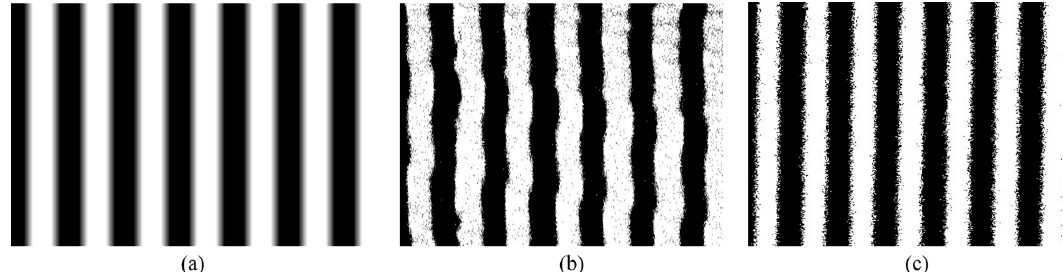
Figure 12. ( a )TheoriginimageoflightanddarkstripestobedisplayedbytheOptical-Microeletromechanical Figure 12. ( a ) The origin image of light and dark stripes to be displayed by the Optical- Systems (MOEMS) projection system, the image which is collected by the CCD is calculated by the binary Microeletromechanical Systems (MOEMS) projection system, the image which is collected by the CCD method; ( b ) the CCD captured image projected by the micromirror with the feedback sensitivity is 4.4 mV / V ◦ , is calculated by the binary method; ( b ) the CCD captured image projected by the micromirror with where the pixel error is about 1.5 pixels; ( c ) the CCD captured image projected by the micromirror with the the feedback sensitivity is 4.4 mV/V°, where the pixel error is about 1.5 pixels; ( c ) the CCD captured feedback sensitivity is 6.4 mV / V ◦ , and the pixel error is about 0.5 image projected by the micromirror with the feedback sensitivity is 6.4 mV/V°, and the pixel error is about 0.5 pixels.